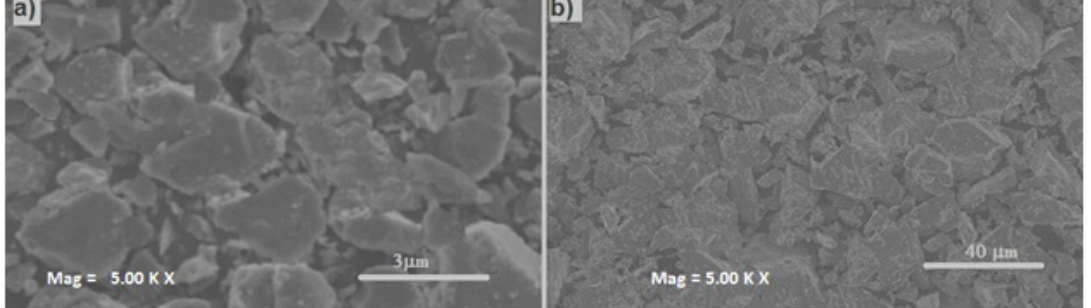
Figure 3. SEM image of (a) Ti and (b) Ni Powders.